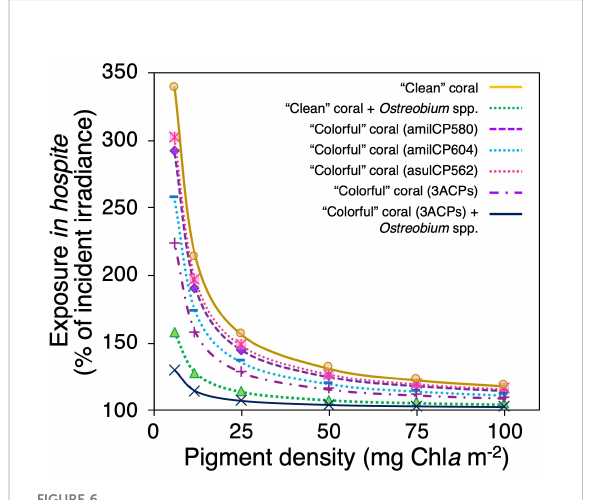
FIGURE 6 Modi fi cation of the light environment in hospite as a function of the pigment content for different coral scenarios, a “ clean ” coral with a white skeleton (yellow solid line), a coral with an Ostreobium bloom in the skeletal surface (green dotted line), a “ colorful ” coral with the chromoprotein asulCP562 upregulated in its tissue (pink dotted line), a “ colorful ” coral with the chromoprotein amilCP580 upregulated in its tissue (purple dashed line), a “ colorful ” coral with the chromoprotein amilCP604 upregulated in its tissue (clear blue dotted line), a “ colorful ” coral with the three chromoproteins upregulated in its tissue (purple dotted-dashed line), and a “ colorful ” coral with the three chromoproteins upregulated in its tissue and with an Ostreobium bloom in the skeletal surface (navy blue solid